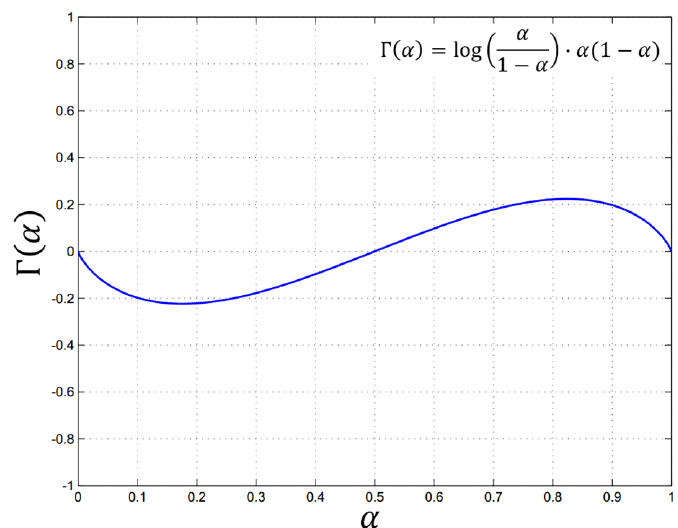
Figure 5. Distribution graph of Γ ( α ) function. The extremum of Γ ( α ) is less than 0.25, while α ranges from 0 to 1. The interval of α is generally set (0.5, 1) in the AlphaMEX Global Pool.